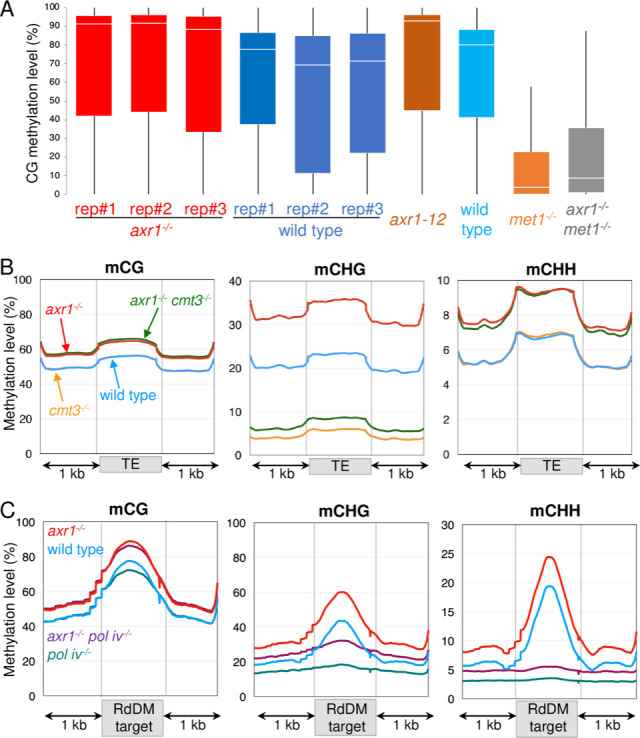
Patterns of DNA methylation in somatic cells of axr1-/-
cmt3-/-, axr1-/-
met1-/- and axr1-/-
pol iv-/- double mutants.A: Boxplots showing mean methylation content of axr1-/- or axr1-12 mutants and the corresponding Col-0 wild type (WT) compared to axr1-/-
met1-/- and met1-/- mutants. The Arabidopsis genome (TAIR10) was partitioned in non-overlapping 100 bp-tiles and methylation levels correspond to the ratios of methylated cytosines over the total number of cytosines. Only cytosines covered by at least five reads were considered. All biological replicates are shown. B and C: Patterns of methylation in TEs (B) and RdDM targets (C) in the Col-0 wild type, axr1-/-, cmt3-/-, pol iv-/- single mutant and the double axr1-/-
cmt3-/- and axr1-/-
pol iv-/-. The average methylation level of TEs or RdDM targets was determined by dividing the corresponding annotated regions into 100 bp bins. Regions located 1 kb upstream and 1 kb downstream are shown. The average methylation levels were determined by combining the biological replicates for each genotype.